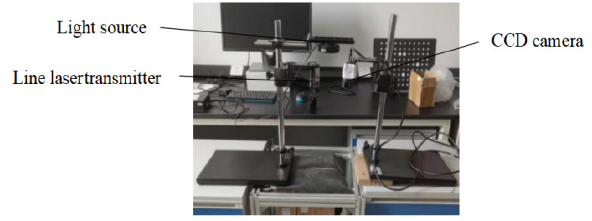
Figure 12. Experimental device.